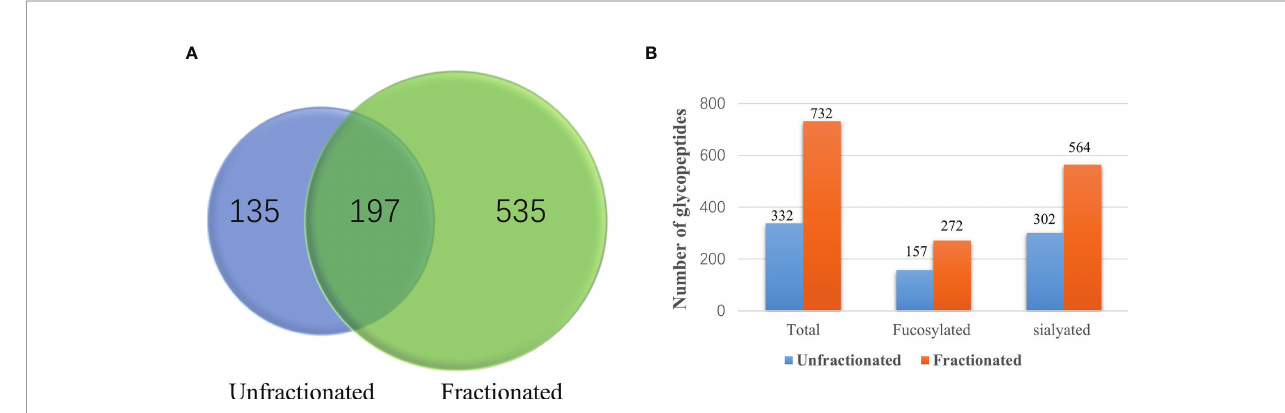
FIGURE 2 | Comparisons of the number of unfractionated and fractionated glycopeptides from pooled late-stage HCC samples. (A) Venn diagram showing the number of glycopeptides from unfractionated and fractionated glycopeptides. (B) Comparison of the number of total glycopeptides, fucosylated glycopeptides and sialylated glycopeptides between the unfractionated and fractionated